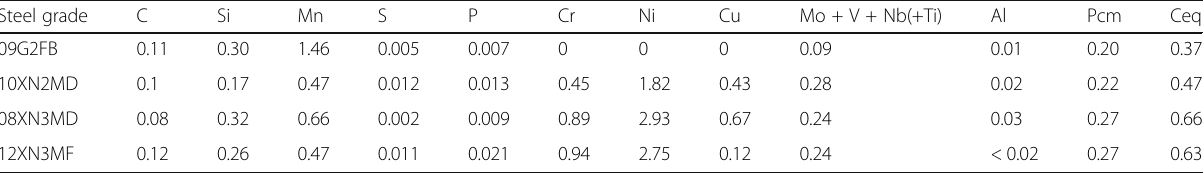
Table 1 The chemical composition of analyzed steels (measured) Steel